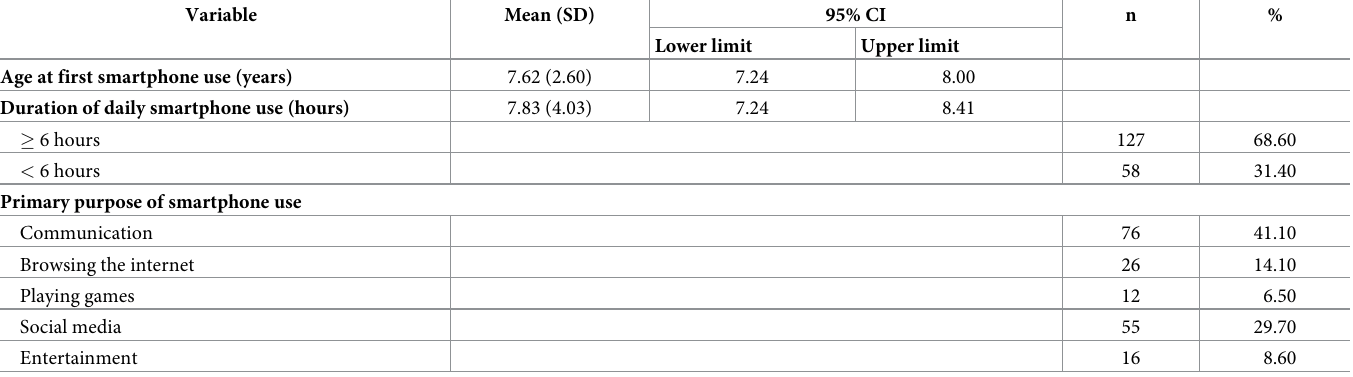
The purpose of smartphone use: Gender comparisons and play games (19.40%). On the other hand, women used smartphones to communicate with significant gender difference in the use of smartphones for the purpose of playing games ( χ 2 = 21.69, p < 0.001; Table 3).